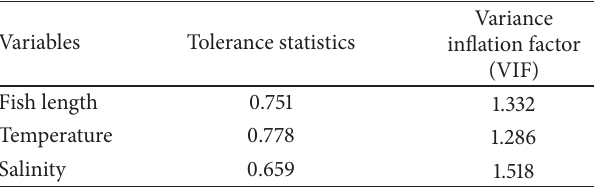
Table 3: Variance inflation factor values of predictor